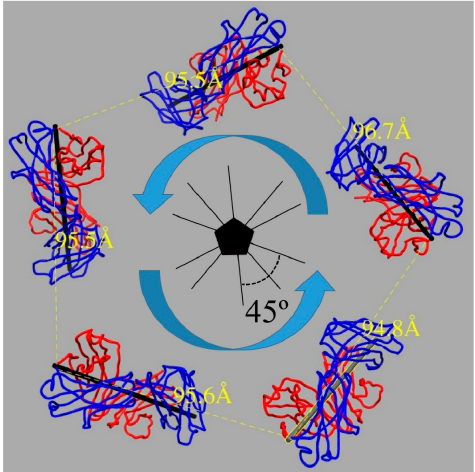
Figure 4. U4 Fab bound the HPV16 capsid in a heavy chain (blue) followed by the light chain (red) mode around each five-fold vertex in a counterclockwise direction (blue arrow). The distance between the neighboring heavy chain C-termini (yellow) at the constant domain was measured to discriminate between monovalent and bivalent binding of U4 Mab. The pseudo-two-fold axis of the Fab (black stick) is indicated and the angle between neighboring axes was 45 degrees.